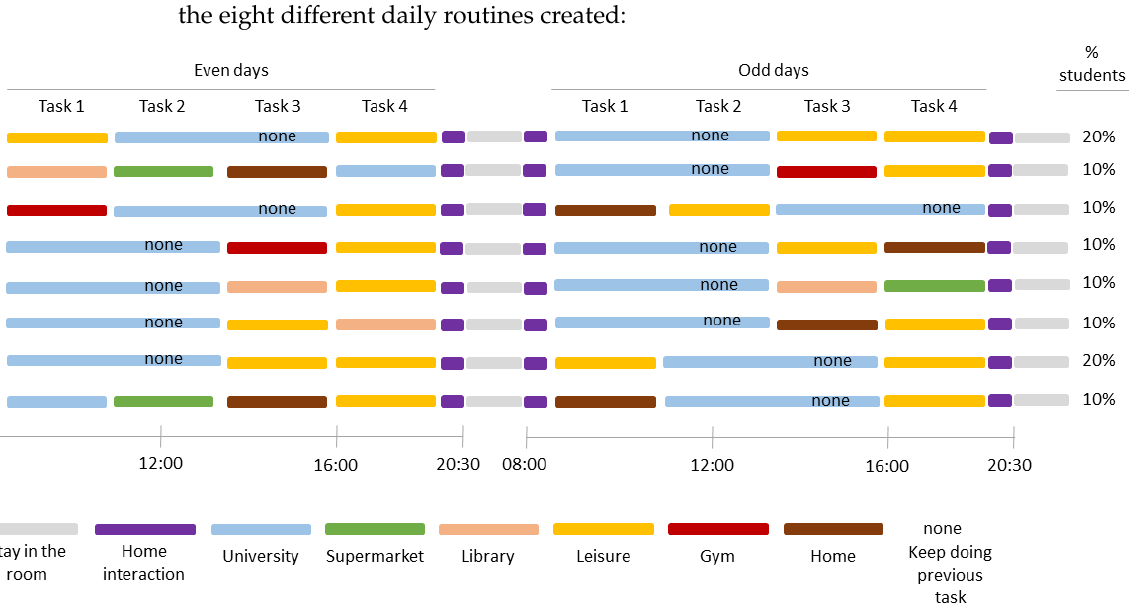
Figure 4. Defined daily routines followed by different percentage of students. ‘Stay in the Room’ task refers to the time students are located within their own rooms without any interaction with other students; ‘Home Interaction’ task refers to the daily interactions’ students have with their flat mates during the early mornings and late evenings. ‘University’, ‘Supermarket’, ‘Library’, ‘Leisure’ and ‘Gym’ tasks refer to interactions within faculty, supermarket, library, leisure and gym buildings, respectively; the ‘Home’ task refers when students go home during the day and spend some time in common areas but not necessarily interacting with other students depending on their schedules; while ‘None’ indicates a student continues with the previous task.